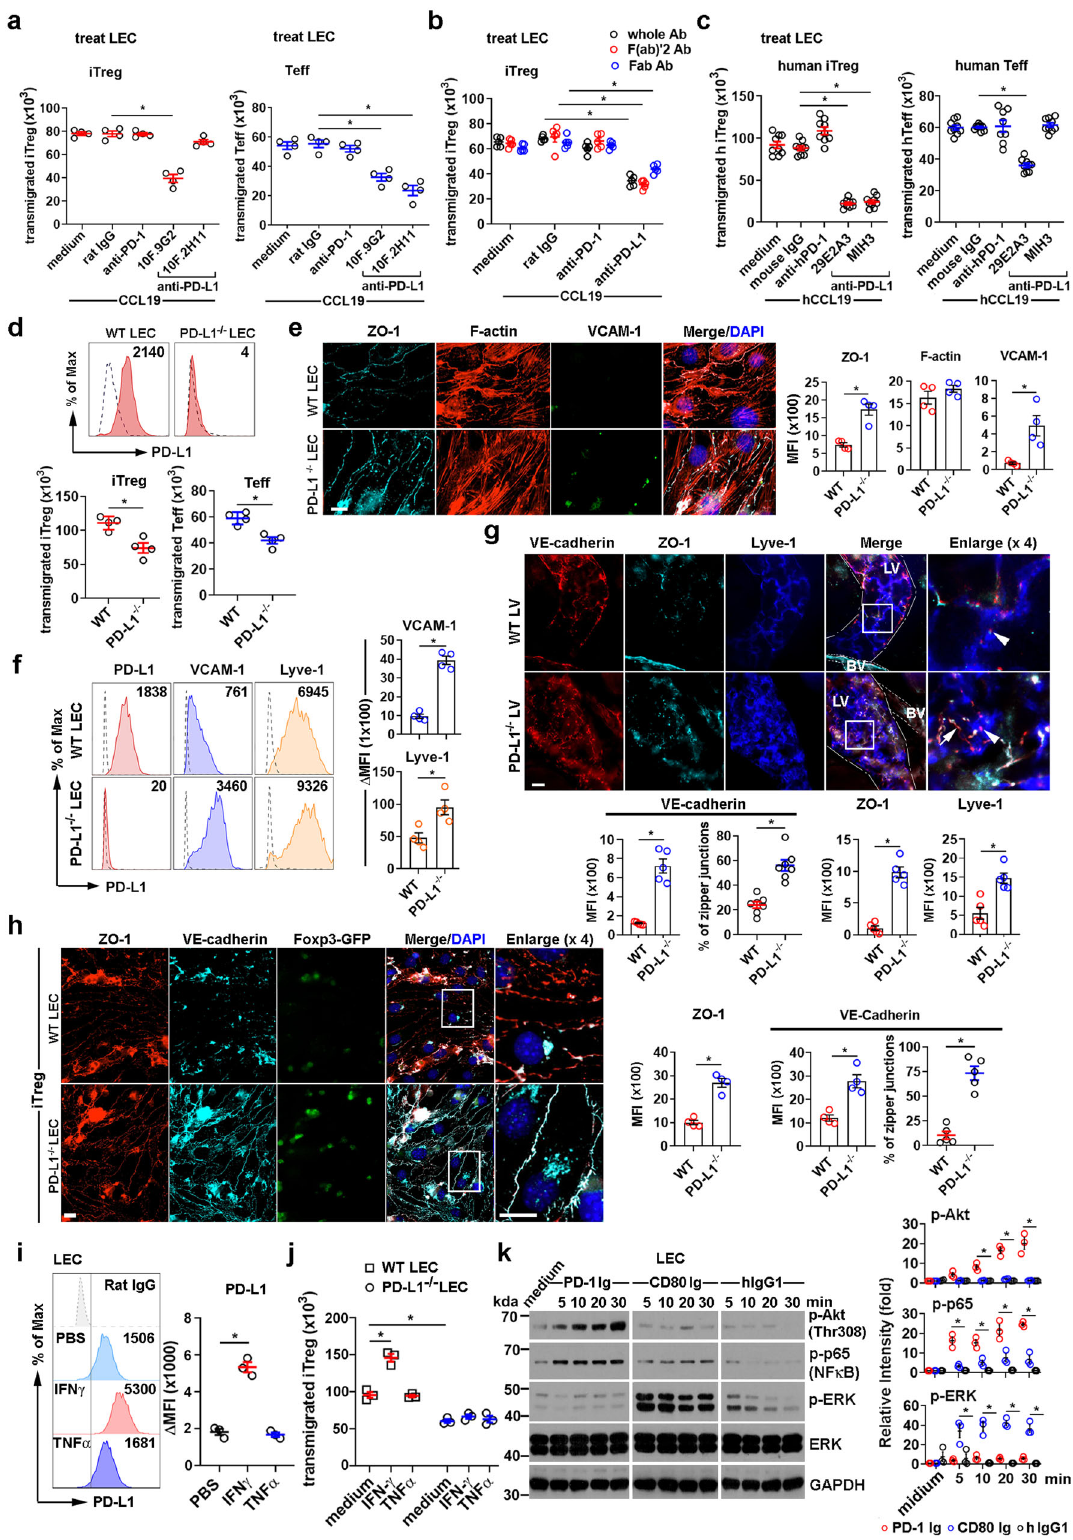
zipper junctional VE-cadherin and button junctional ZO-1 (Fig. 3g), supporting the functional importance of the organiza- tion of the junctional proteins in endothelial buttons and zippers 31,32 . PD-L1 − / − LVs also had increased VCAM-1